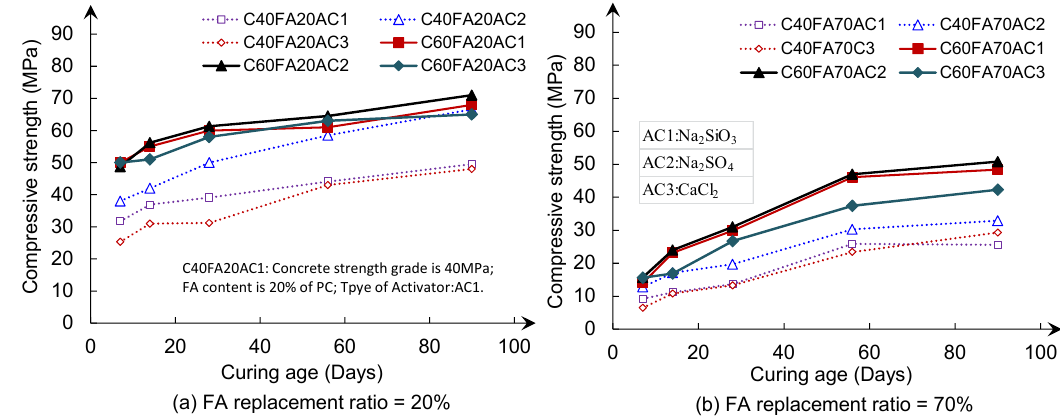
Figure 4. Effect of activator type (the dosage is 1.50% of the binder) on the compressive strength of FAC.